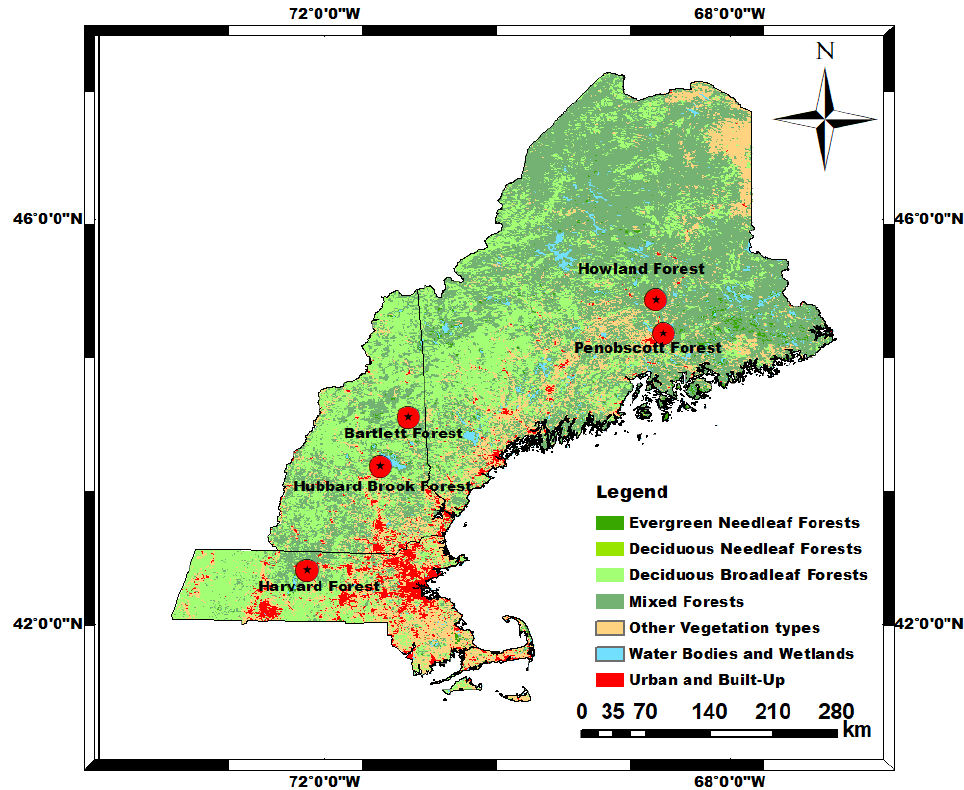
Figure 1. The study sites are distributed in the Howland Forest (lat: 42.20°, lon: − 68.73°), Penobscot Forest (lat: 44.87°, lon: − 68.65°), Bartlett Forest (lat: 44.04°, lon: − 71.16°), Hubbard Brook Forest (lat: 43.56°, lon: − 71.45°), and Harvard Forest (lat: 42.53°, lon: − 72.17°); all are located in the US; the base map is provided by MODIS land cover product MCD12Q1.